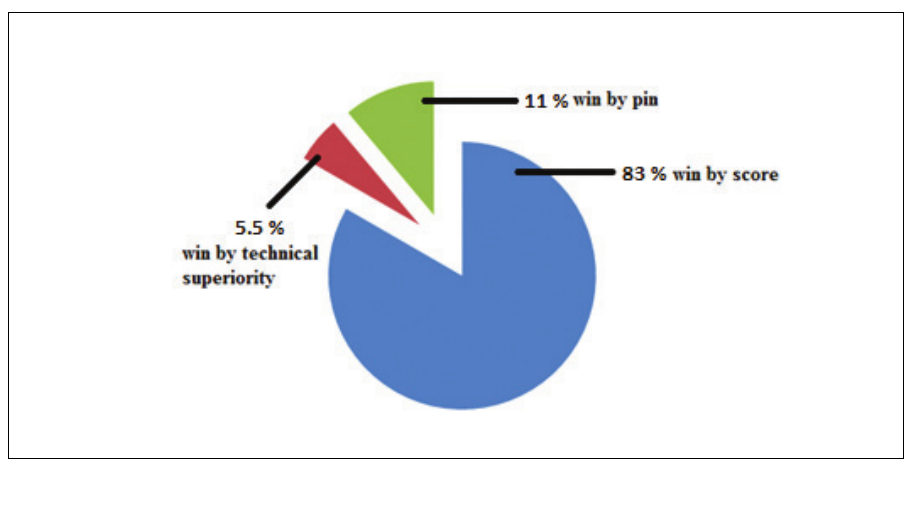
Figure 7. The percentage distribution of coaches’ to - tal objections against the referee